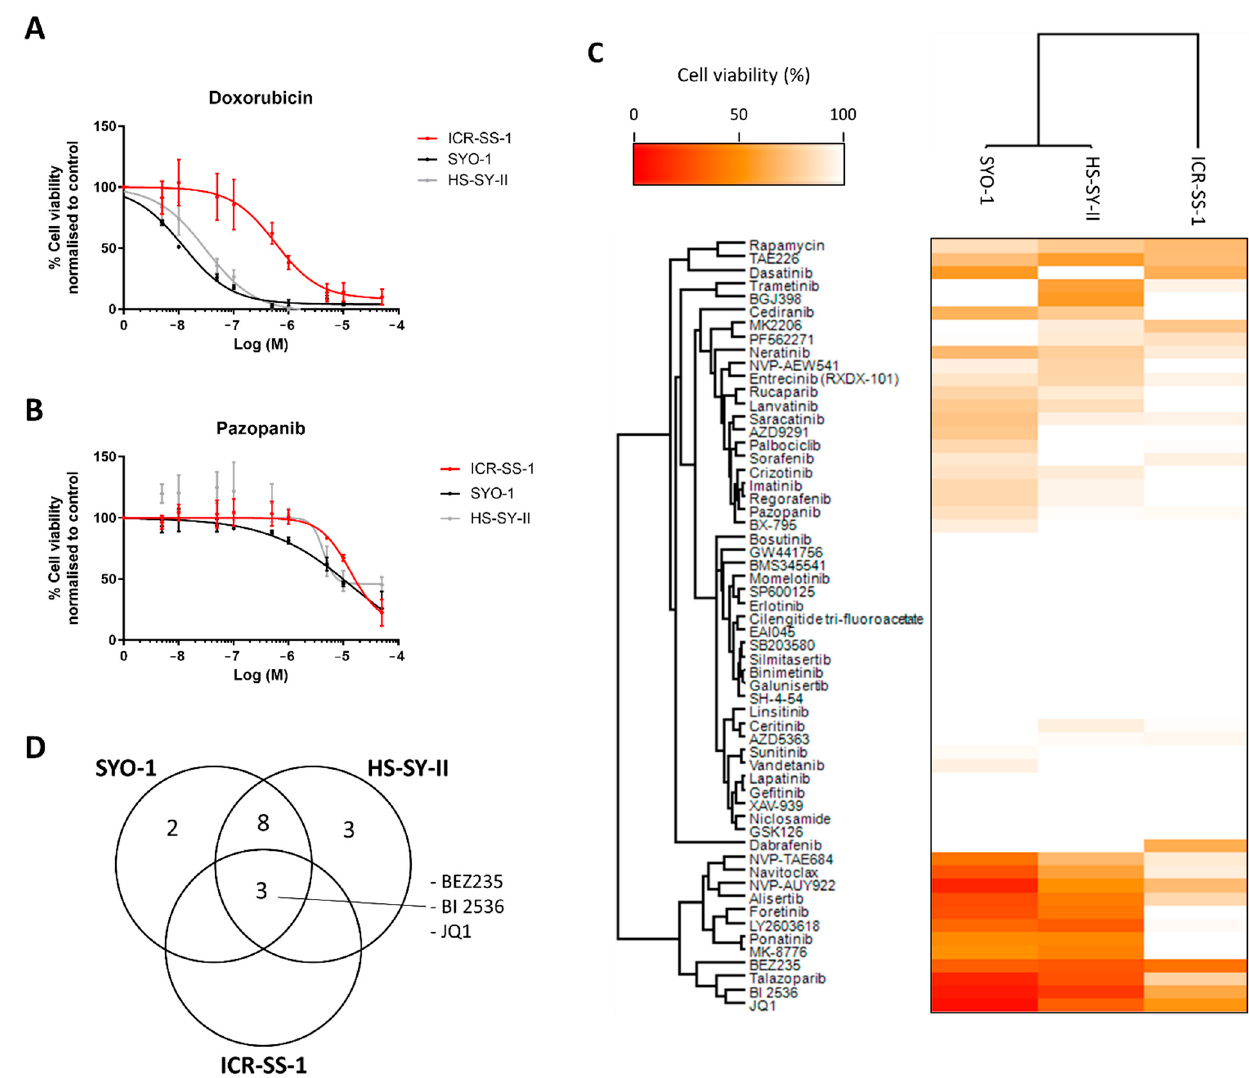
Figure 6. ( A ) Dose–response curves of ICR-SS-1, SYO-1, and HS-SY-II treated with doxorubicin. n = 3. ( B ) Dose–response curves of ICR-SS-1, SYO-1, and HS-SY-II treated with pazopanib. n = 3. ( C ) A heatmap of drug response of ICR-SS-1, SYO-1, and HS-SY-II cell lines upon treatment with 58 targeted small molecule inhibitors at 500 nM or in the case of NVP-AUY922, 50 nM. n = 3. ( D ) Venn diagram of shared and unique targeted inhibitor sensitivities (<65% viability) across the three cell lines.